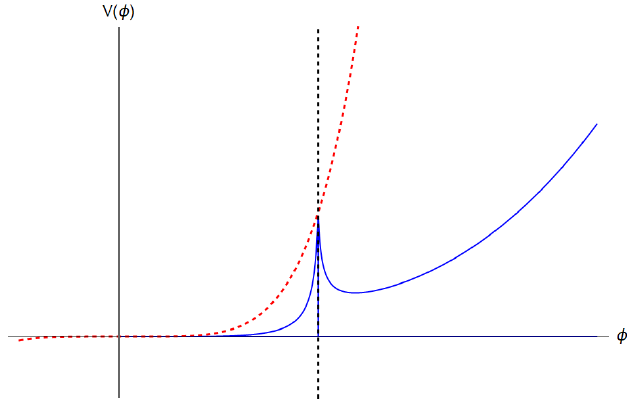
Figure 7 . LL effective potential for the φ 5 theory. The blue line is the LL numerical solution, the red dashed line is the classical potential.